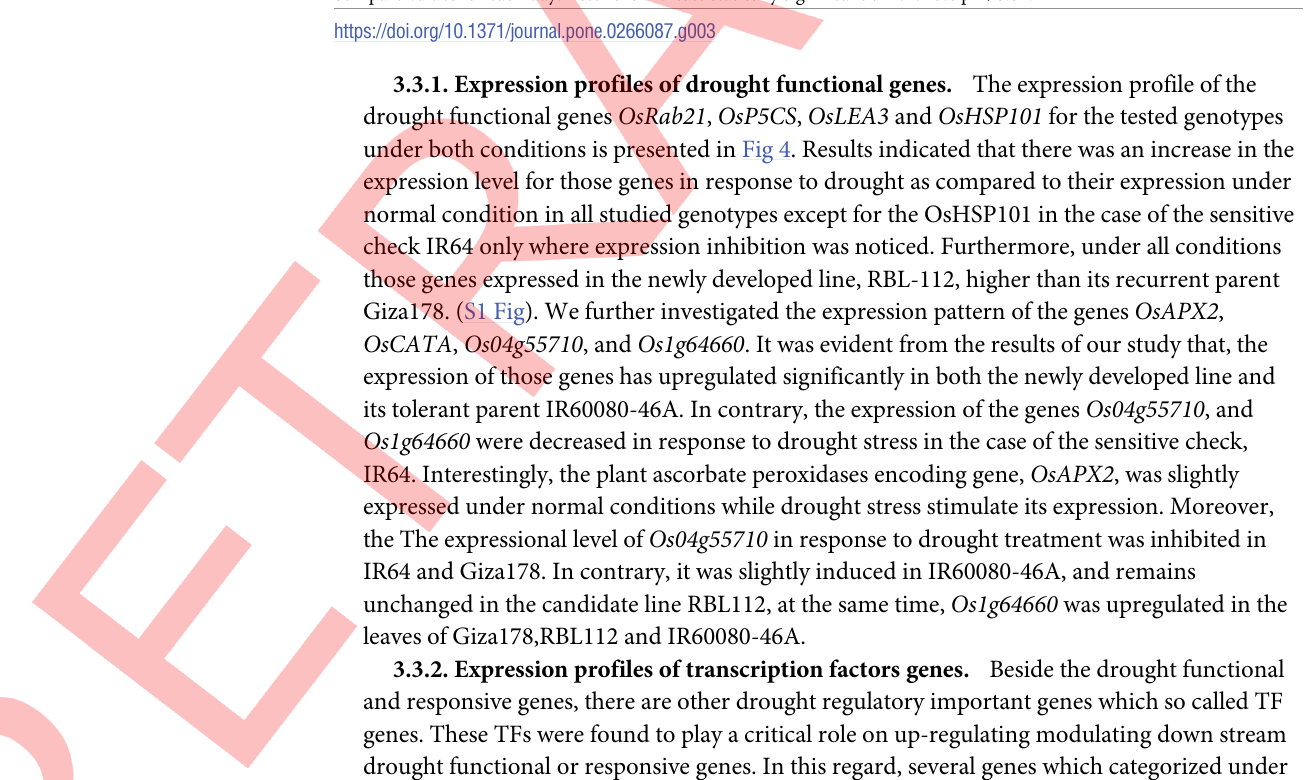
Fig 3. Dark adapted Fv /Fm values over drought period in the four genotypes. One way ANOVA were performed to compare values for each day. Asterisks indicate statically significant differences p <